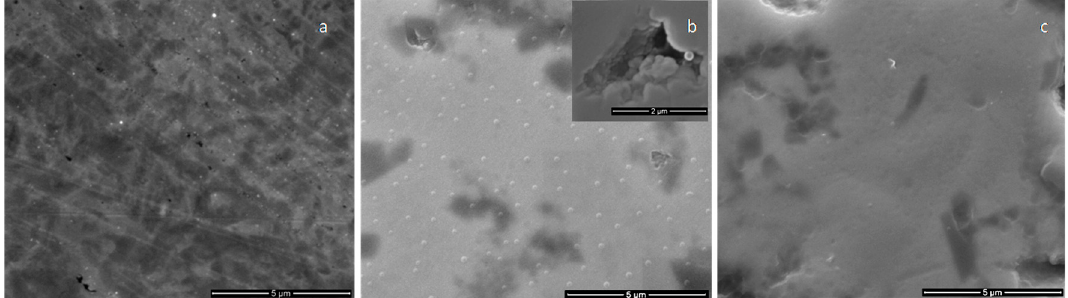
Figure 6. SEM images of: ( a ) Ti substrate; and of the calcium phosphate coatings generated on Ti substrate at: ( b ) p = 1.2 × 10 − 2 mbarr; and ( c ) p = 4.6 × 10 − 3 mbarr; Ar gas working pressures.